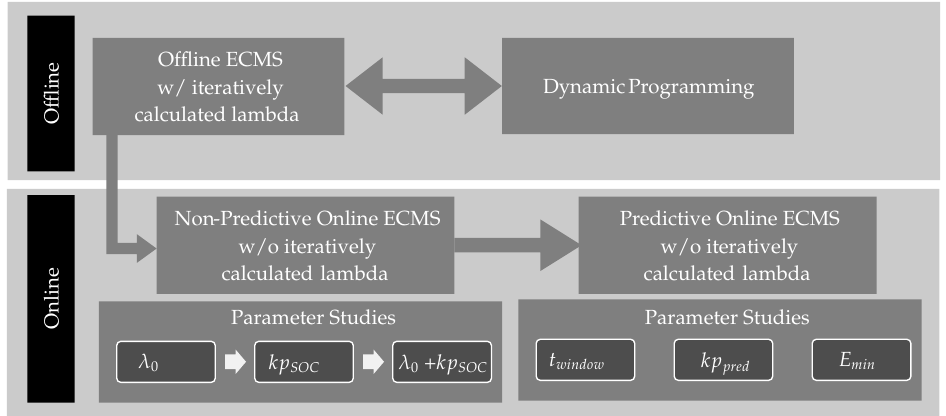
Figure 1. Applied methodology to determine optimal control in offline and online